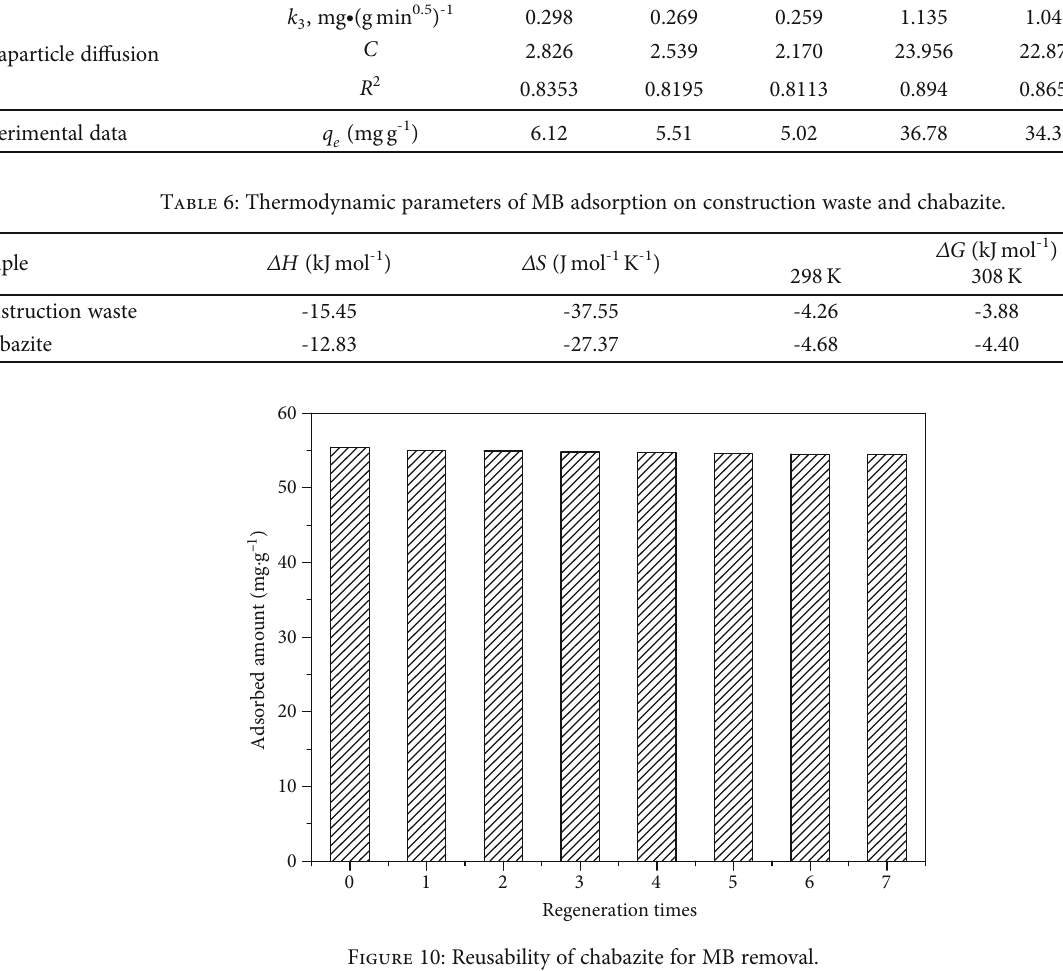
Figure 10: Reusability of chabazite for MB